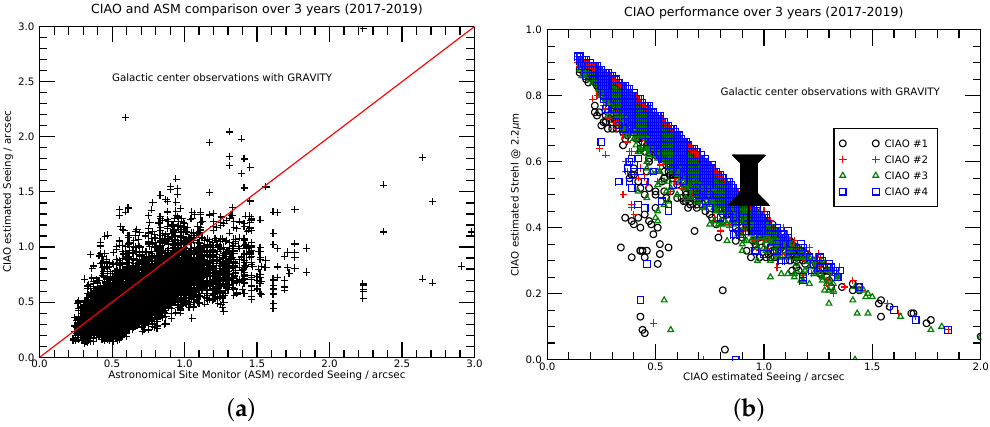
Figure 5. Estimated CIAO seeing and CIAO performance results for 3 years of Galactic Center (GC) observations with GRAVITY. ( a ) CIAO estimated seeing vs recorded Paranal Astronomical Site Monitor (ASM) seeing; ( b ) CIAO estimated K-band Strehl number vs CIAO estimated seeing (at λ = 0.5 µ m and air mass along the line of sight). The pushpin points to our simulation